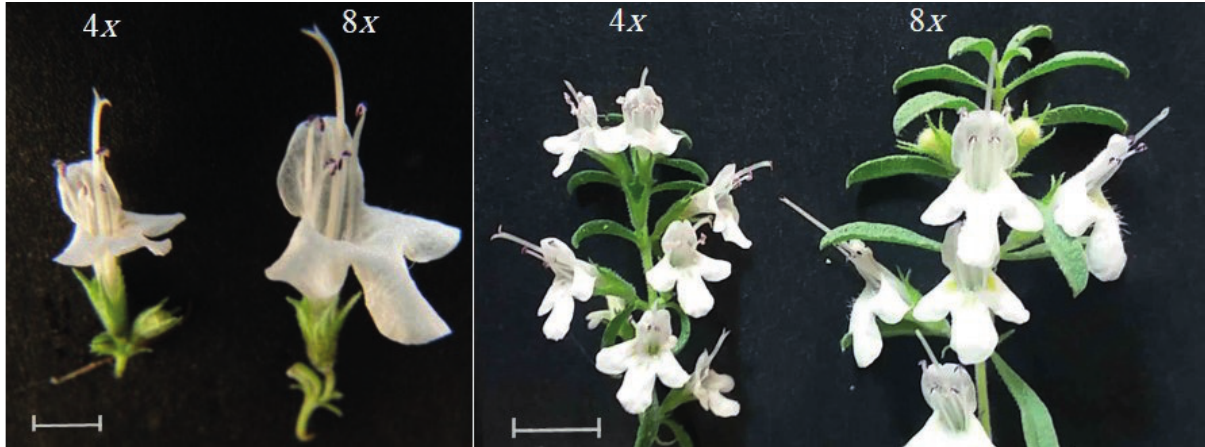
Figure 6. Comparison of the flower morphology between tetraploid (4 x ) and octaploid (8 x ) S. mutica . Bars = 5 mm